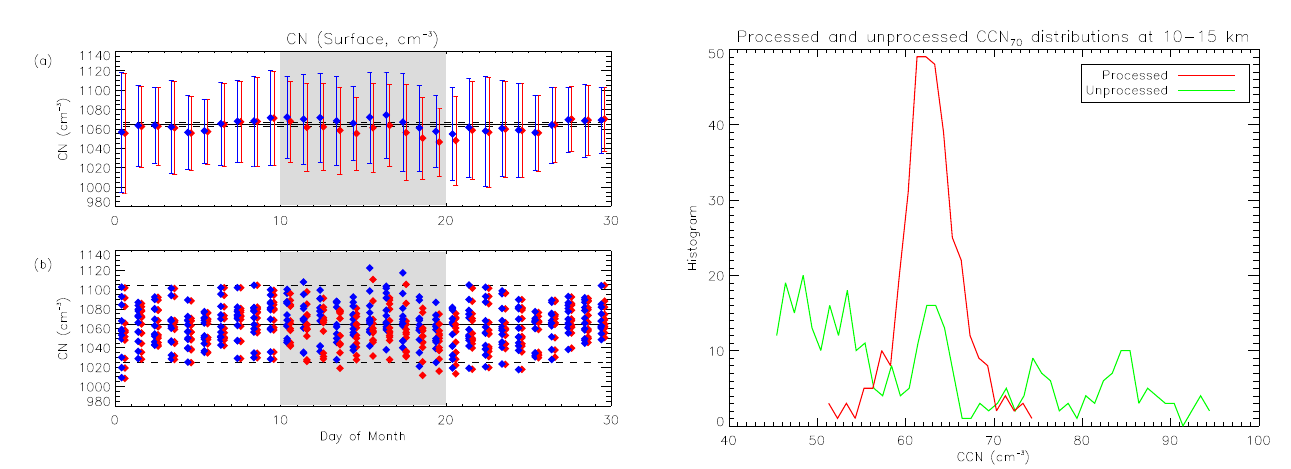
Fig. 6. Histograms showing the distribution of processed and un- processed CCN 70 concentrations at 10–15km. The null hypothesis that the red line (processed) is normally distributed is rejected by the Lilliefors